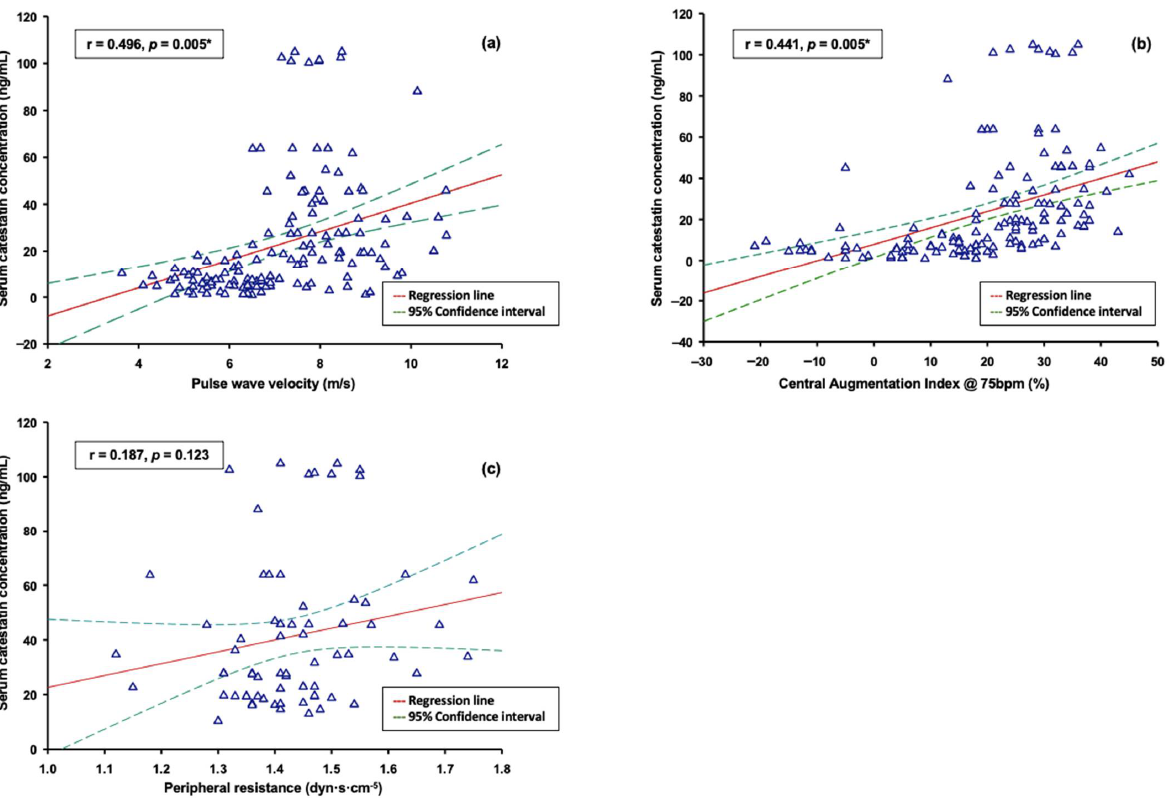
Figure 4. Correlation analysis between serum catestatin concentrations and indices of arterial stiffness: ( a ) correlation with PWV; ( b ) correlation with cAIx-75; ( c ) correlation with peripheral resistance. Abbreviations: PWV: pulse wave velocity; cAIx-75: central augmentation index at 75 beats-per-minute. * Spearman rank correlation analysis.